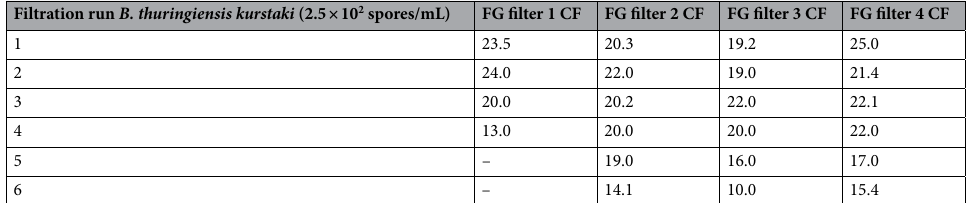
Table 5. Concentration factors of B. thuringiensis kurstaki spores achieved for backwashing and bleaching FG filters reused for up 6 times.